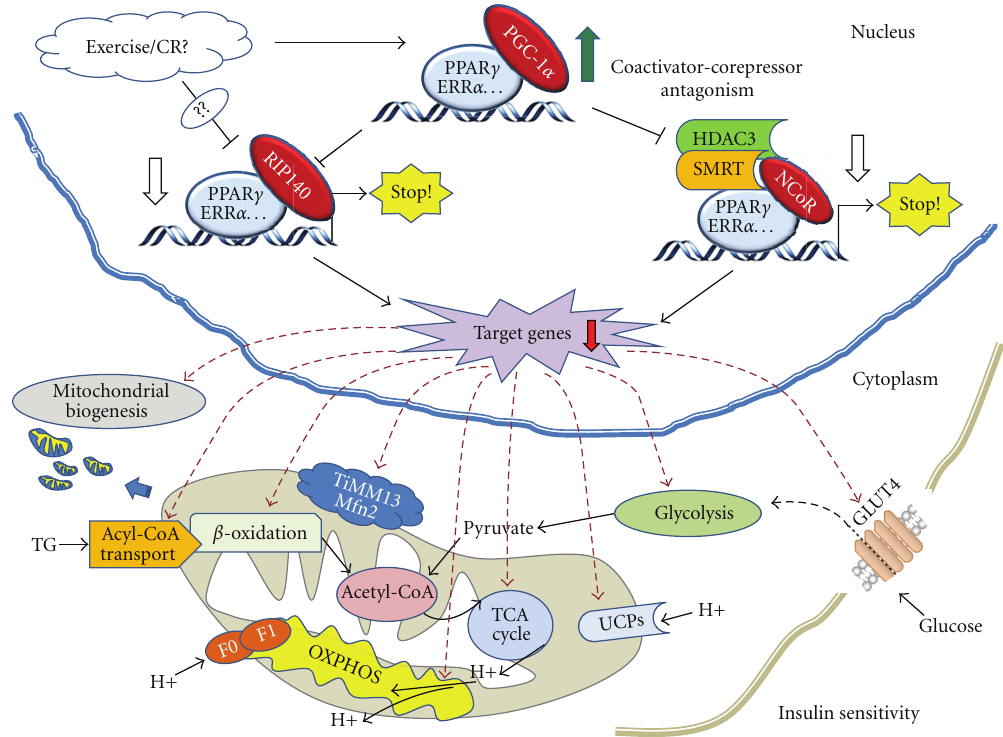
Figure 3: PGC-1 α -NCoRs antagonism controls insulin sensitivity in metabolic tissues. In adipose and skeletal muscle, the transcriptional activity of PPAR γ and ERR α is responsible for the expression of gene networks that control glucose uptake, glycolysis, fatty acid oxidation, TCA cycle, OXPHOS, mitochondrial biogenesis, and uncoupling. Therefore, exercise and calorie restriction prevent obesity and insulin resistance probably by depressing NCoRs and increasing PGC-1 α . PPAR γ , peroxisome proliferator-activated receptor gamma; PGC-1 α : PPARgamma coactivator 1-alpha; ERR α , Estrogen-related receptor alpha; RIP140: the corepressor receptor-interacting protein 140; NCoR: nuclear corepressor; SMRT: silencing mediator of retinoid and thyroid hormone receptors; HDAC3: Histone deacetylases 3; TG: Triglyceride; UCPs: uncoupling proteins; Mfn2: mitofusin 2; TIMM13: mitochondrial import inner membrane translocase subunit Tim13; OXPHOS: oxidative